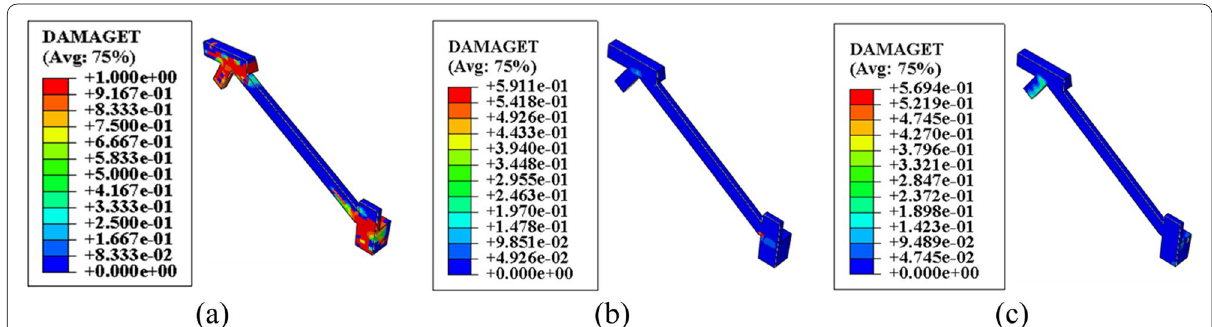
Fig. 11 Contours of tensile damage distributions of member 11 made using different materials: a conventional concrete; b SHCC ( σ t 0 4%; σ tu 8 MPa); and c UHPC ( σ t 0 = =